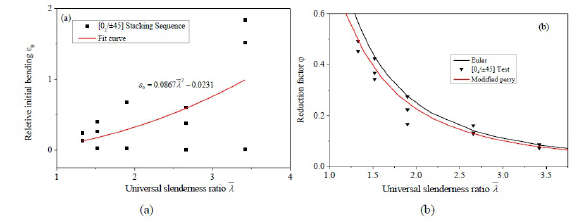
Figure 8: Stacking sequence [0 4 / ± 4 5 ] (a) initial relative bending